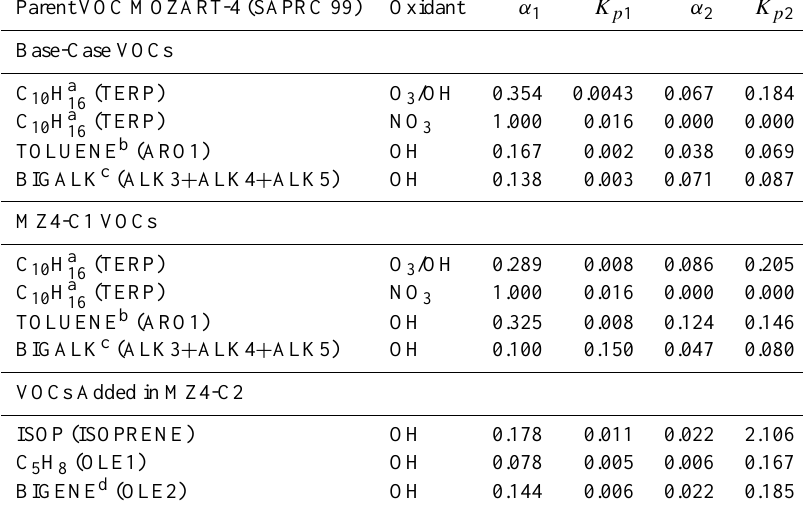
Table 1. Base-case and revised SOA parameters (MZ4-C1) for original and newly treated parent VOCs (MZ4-C2) in MOZART-4. Base-case parameters are the default model parameters normalized for ρ = 1.0gcm − 3 and T = 298K. Revised parameters also are for ρ = 1.0gcm − 3 and T = 298K and are based on 2p-VBS fits with the exception of NO 3 oxidation of monoterpenes and OH oxidation of isoprene, which are based on Chung and Seinfeld (2002) and Henze and Seinfeld (2006), respectively. Parent VOC MOZART-4 (SAPRC 99) Oxidant α 1 K p 1 α 2 K p 2 Base-Case VOCs